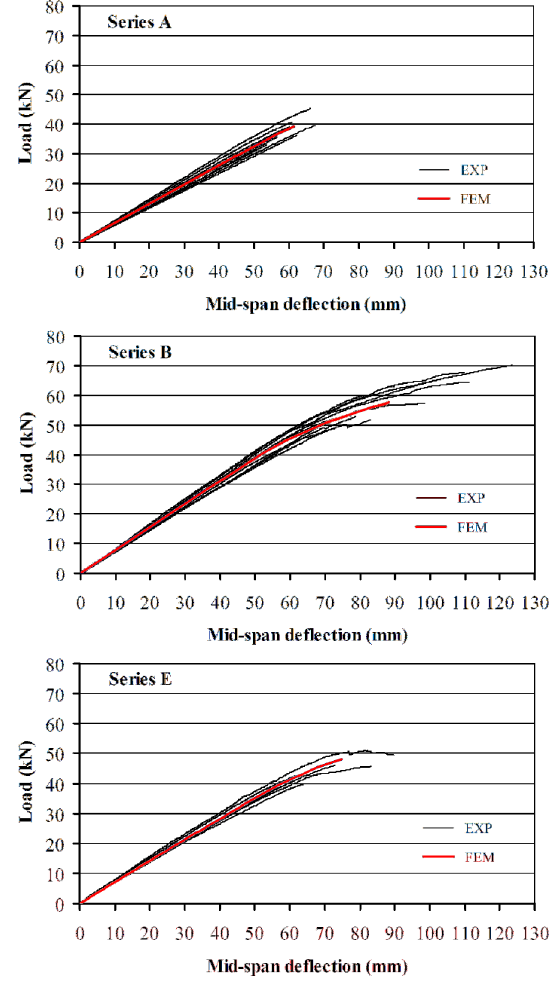
Fig. 7. Load-deflection curves for unreinforced (Series A) and reinforced (Series B and Series E) beams: comparison between experimental tests and numerical